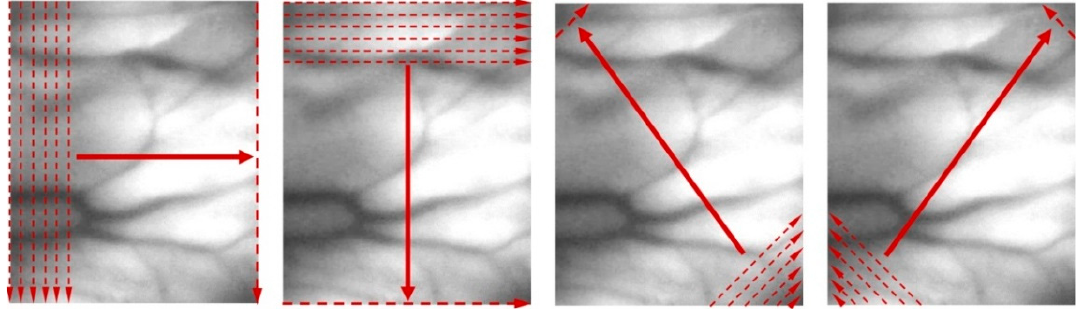
Figure 8. Vein pattern ROI extraction: ( a ) reference point for ROI; ( b ) ROI for vein extraction; and ( c ) result of ROI.